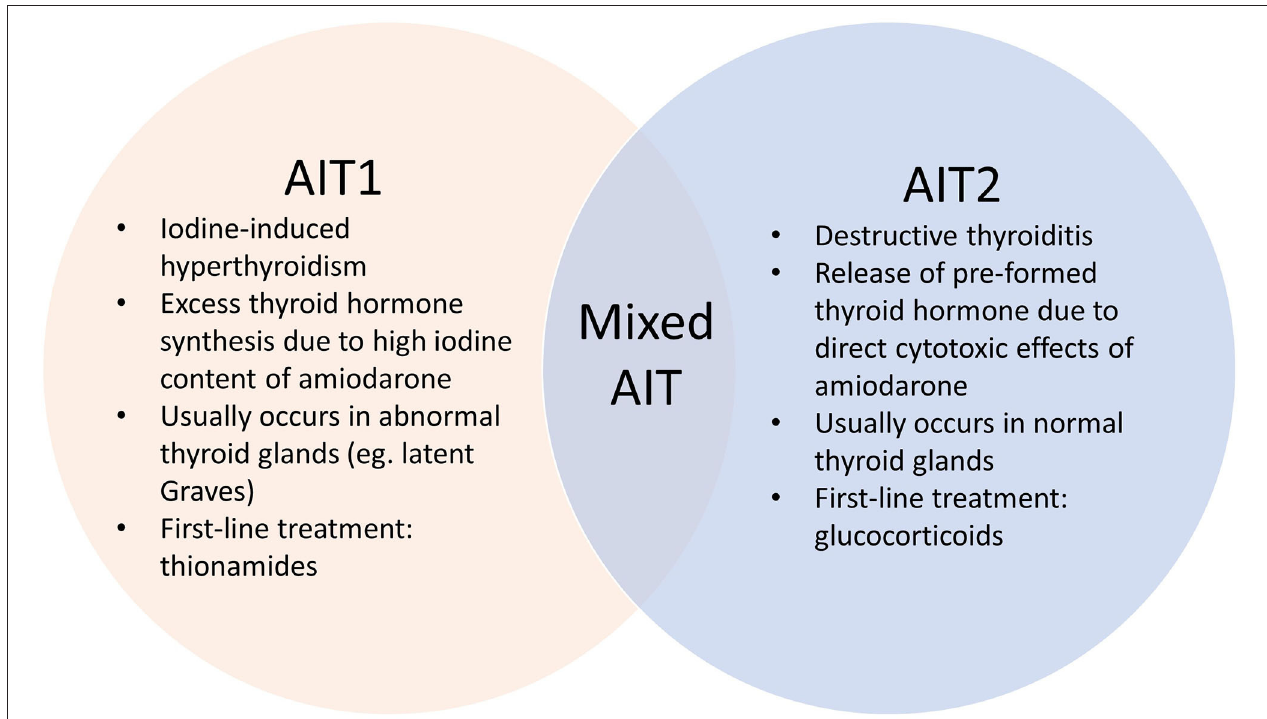
FIGURE 1 | Pathophysiology of various AIT